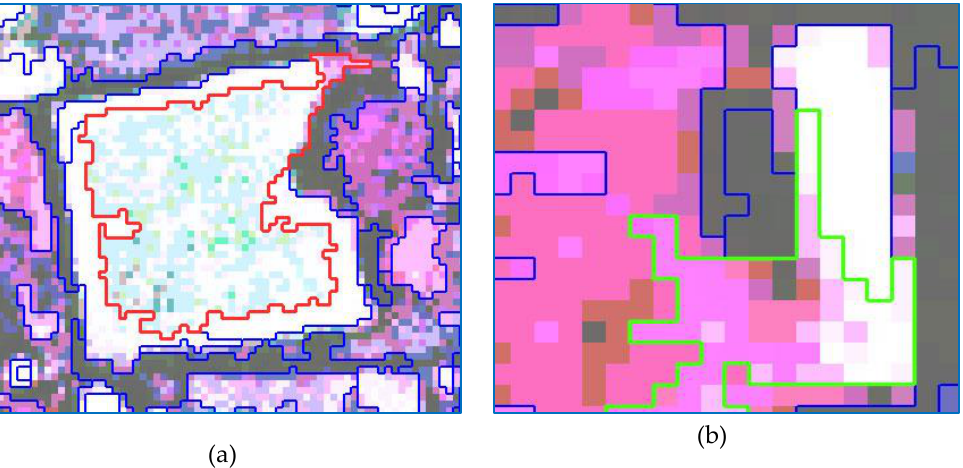
Figure 12. Visualization of over- and under-segmented errors of buildings. ( a ) The red line corresponds to an over-segmentation result, whereas the whole white color represents the building. ( b ) The green line corresponds to an under-segmentation result, whereas some portions of the building (white color) merged with other urban features (purple color).